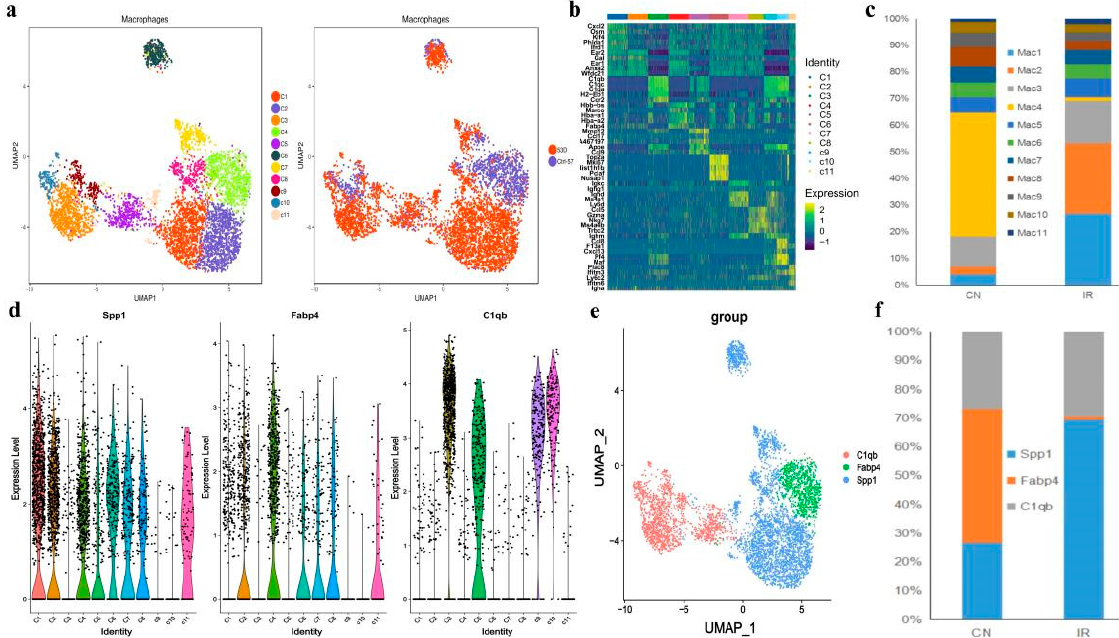
Figure 6. Single-cell transcriptional profiling of macrophages cells. ( a ) The t-distributed stochastic neighbor embedding (t-SNE) plot of the 11 identified cell types in macrophages cells. ( b ) Heatmap of the DEGs among the 11 cell subtypes, where the colors from red to blue represented alterations from high expression to low expression. ( c ) The fraction of cells for macrophages subsets percentage of subsets across individual donors. ( d ) Violin plots showing the normalized expression levels of 3 representative canonical marker genes across the 11 clusters. ( e ) t-SNE of single-cell profile with each cell color-coded by representative novel identified markers of C1qc, Icam1, and Fabp4 across the macrophage populations. ( f ) The bar plot shows the relative contributions of each cluster as in E between PR and CN.